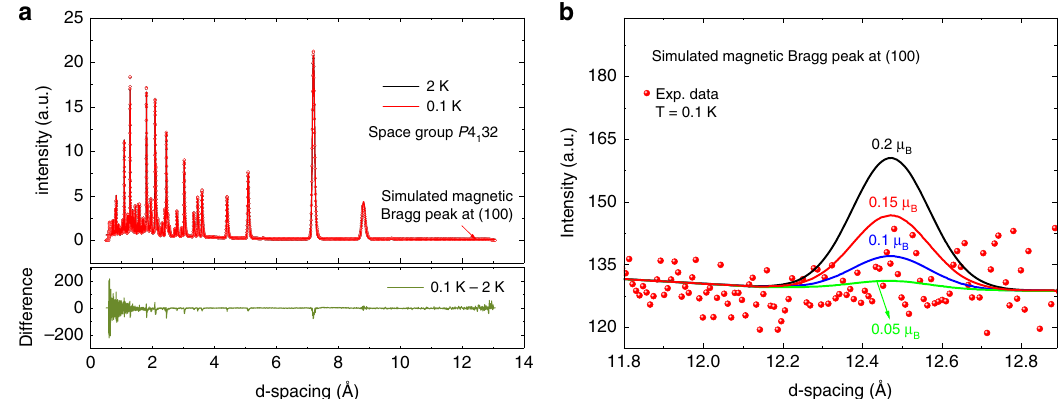
Fig. 2 Powder neutron diffraction patterns of PbCuTe 2 O 6 . a Measured at 0.1 K and 2 K using the WISH high- fl ux diffractometer and plotted as a function of d-spacing. Both patterns are re fi ned in the established cubic space group, P 4 1 32 26 where the lattice constant at 0.1 K is 12.4454(3)Å. The difference between the patterns at these two temperatures is plotted below in green and clearly shows that no magnetic Bragg peaks appear at the base temperature. b Assuming a magnetic structure compatible with the long-range magnetic order found in SrCuTe 2 O 6 , a magnetic Bragg peak is estimated at the (1, 0, 0) re fl ection (12.4454 Å in d-spacing). The expected Bragg peak amplitude is shown for different values of ordered moment per Cu 2 + ion by the curves. Clearly, if present, the maximum ordered moment can be no greater than 0.05 μ B